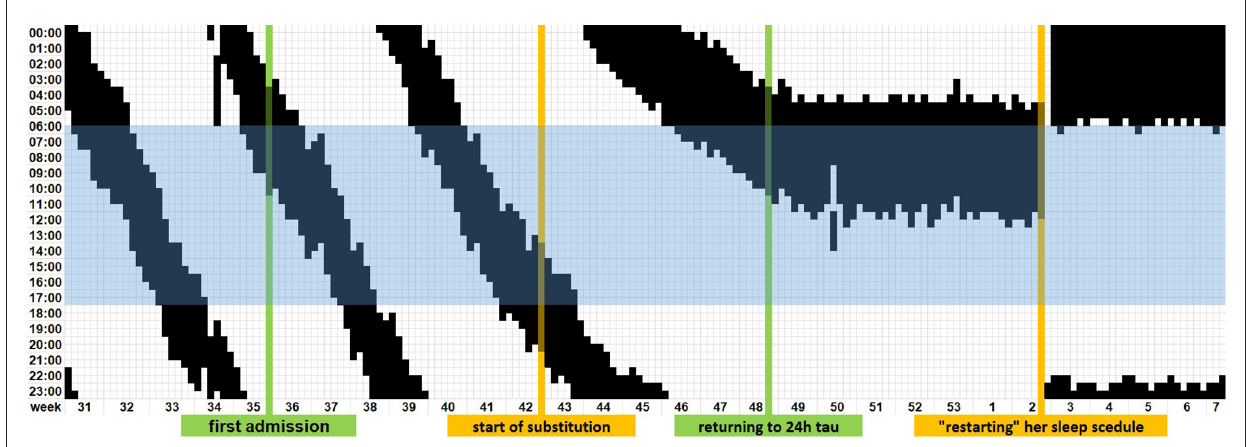
FIGURE2 Timeline of the digitalized patient-reported sleep diary until normalization of the sleep–wake rhythm. The blue highlighted block represents regular working hours in two shifts.